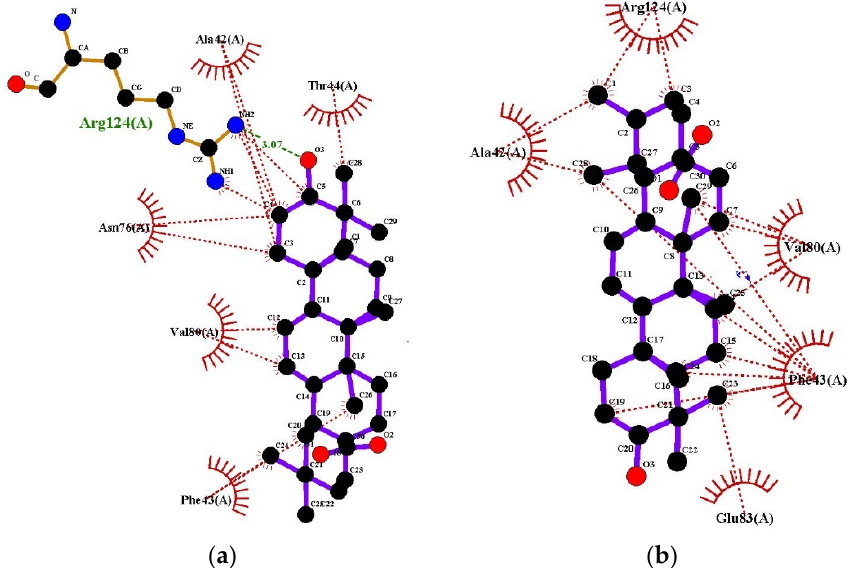
Figure 5. Ligplots showing interacting residues of Human Peroxiredoxin 5 in complex with Oleanolic